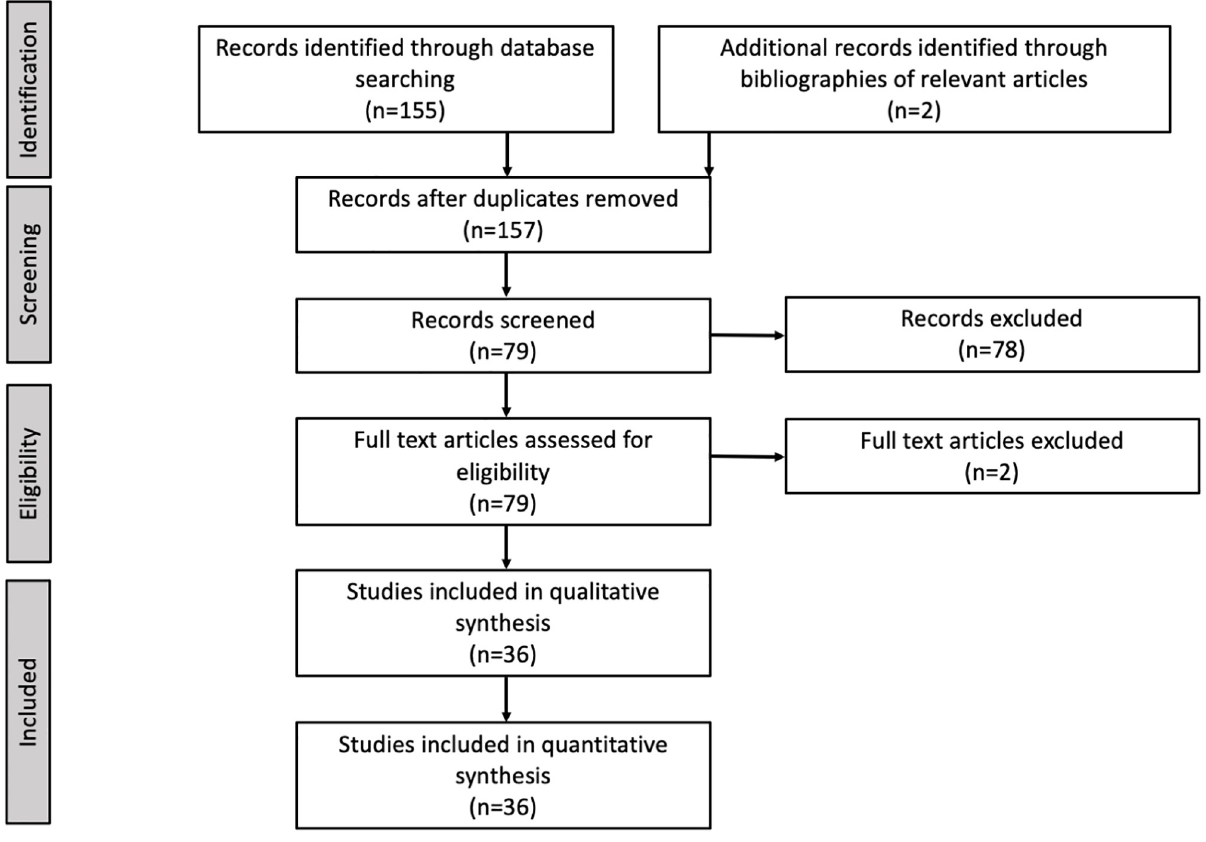
Fig 1. Flow diagram of included